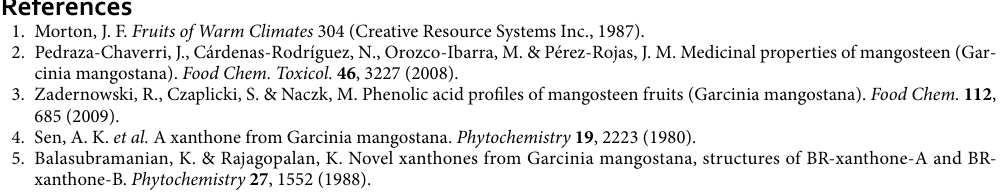
Gold nanoparticles impart different colors depending on their (Localized Surface Plasmon Resonance) LSPR in solution. The colors imparted by the nanoparticle solution were employed to dye cotton fabrics and the stability of the dyes on the fixed fabric was tested. These tests showed a positive result in the dyeing process. In summary, this paper presents an innovative approach to the synthesis and use of gold nanoparticles as novel stable color- ants utilizing the surface plasmon resonance coloring effect of nanogold.